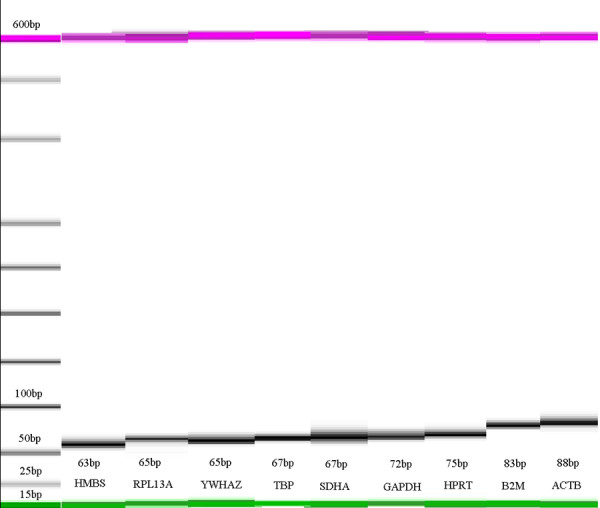
Microfluidic capillary electrophoresis of the sequence reactions identified single bands which corresponded exactly to the expected product size.